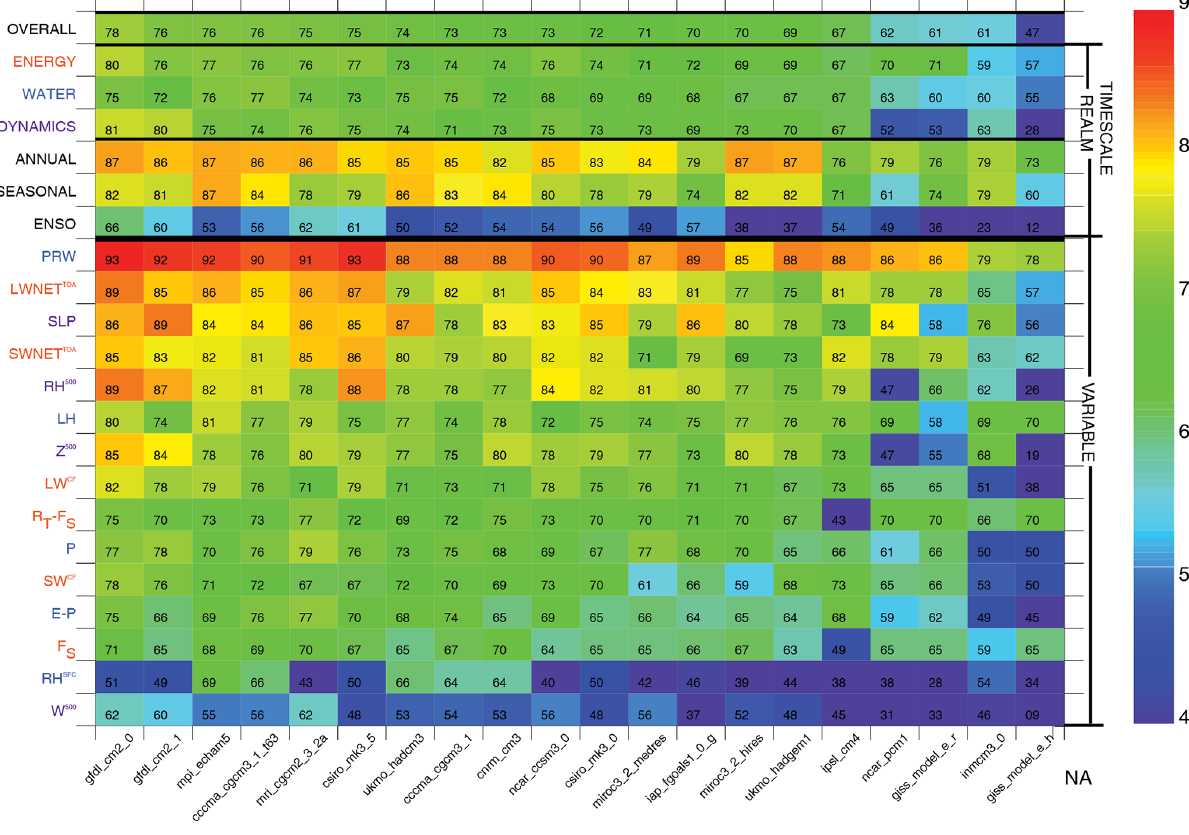
Figure 2. Overall, realm, timescale, and variable scores (ordinate) for historical (20c3m) simulations submitted to the CMIP3 archives (abscissa), sorted by overall score (top row) based on methods employed (see Methods). Simulations and variables are ordered in descending score order from left to right using the overall score and from top to bottom using average variable